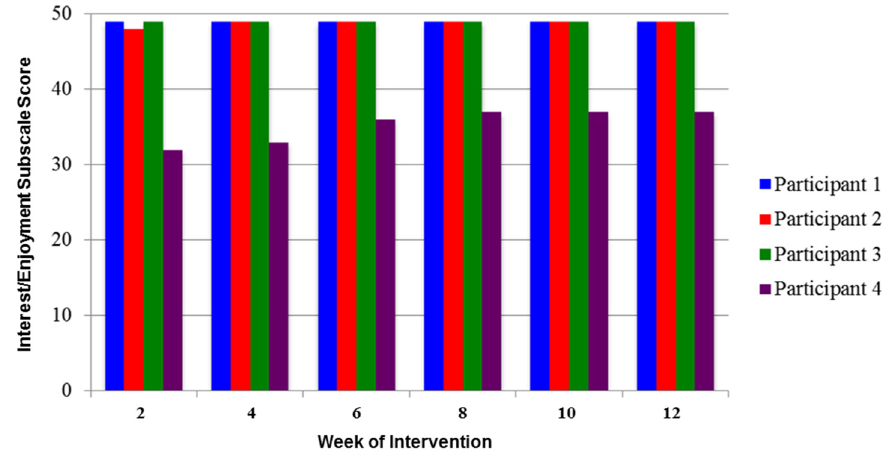
Figure 4. The score for the interest/enjoyment subscale of the Intrinsic Motivation Inventory (maximum score = 49).